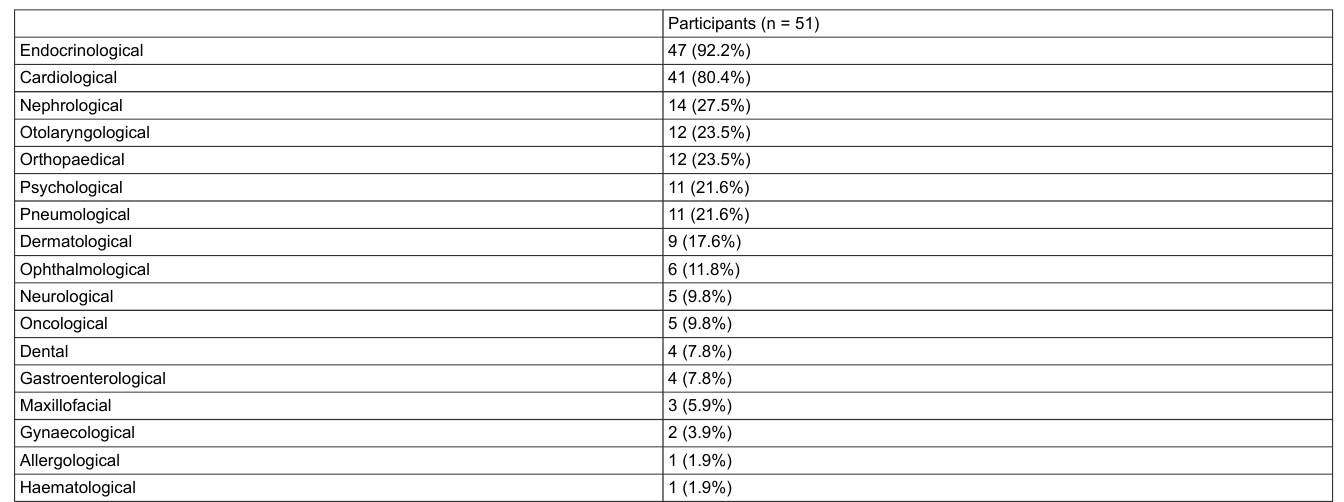
Table S3: Specific